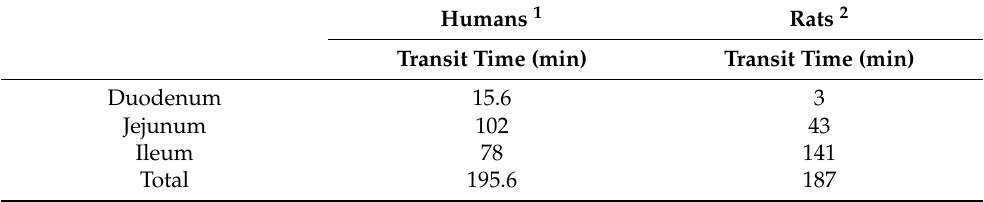
Table 2. Transit time in segments of the intestine in humans and